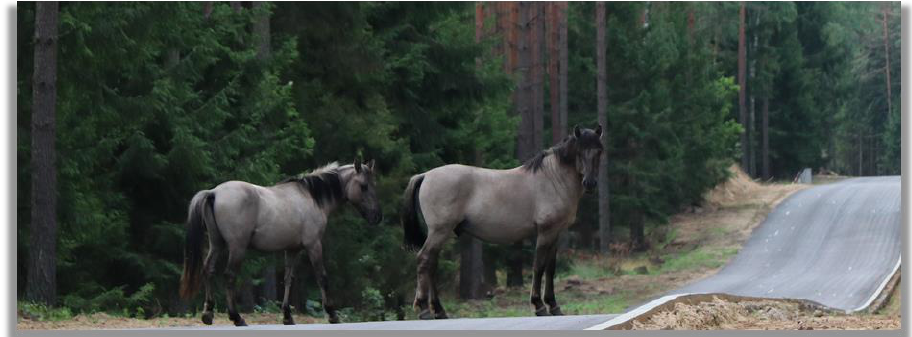
Figure 1. A defeated four-year-old Konik stallion (right) and a recently dispersed two-year-old colt (left) in a bachelor group, Popielno Sanctuary, Poland (photo by Michał Bruzda). Challenges for